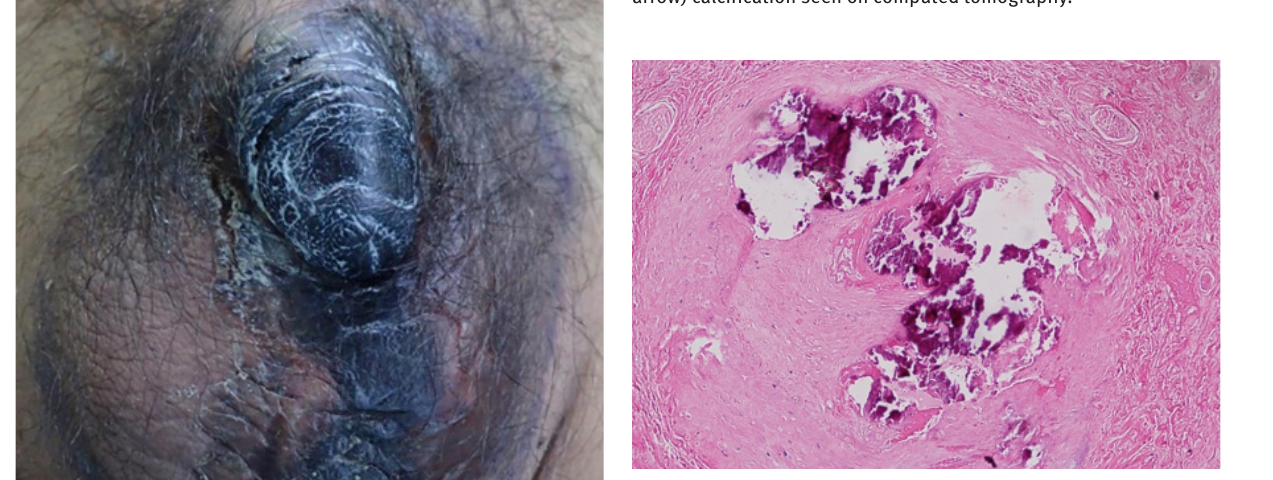
Figure 2: Internal pudendal (large arrow) and penile artery (small arrow) calcification seen on computed tomography.